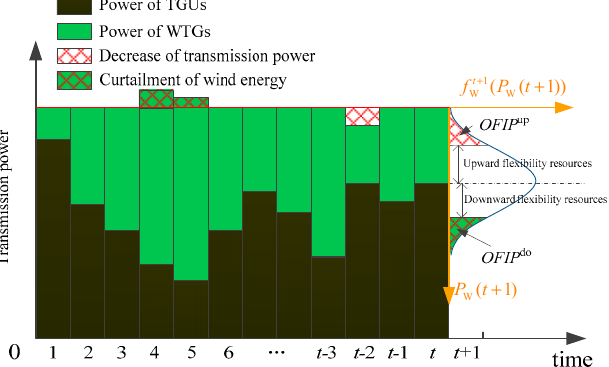
Figure 2. Schematic of operation flexibility for the BWTSGS.